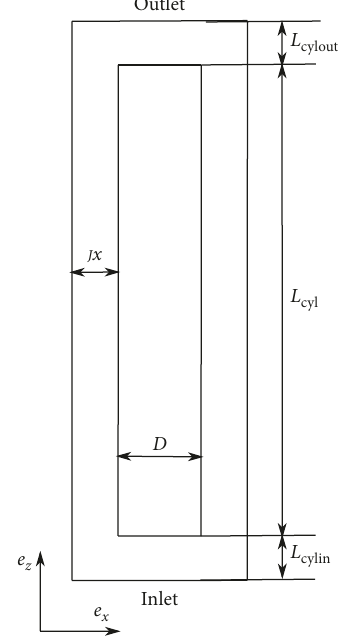
Figure 15: Test configuration for dynamic simulations. Table 3: Confinement values used for the simulations.